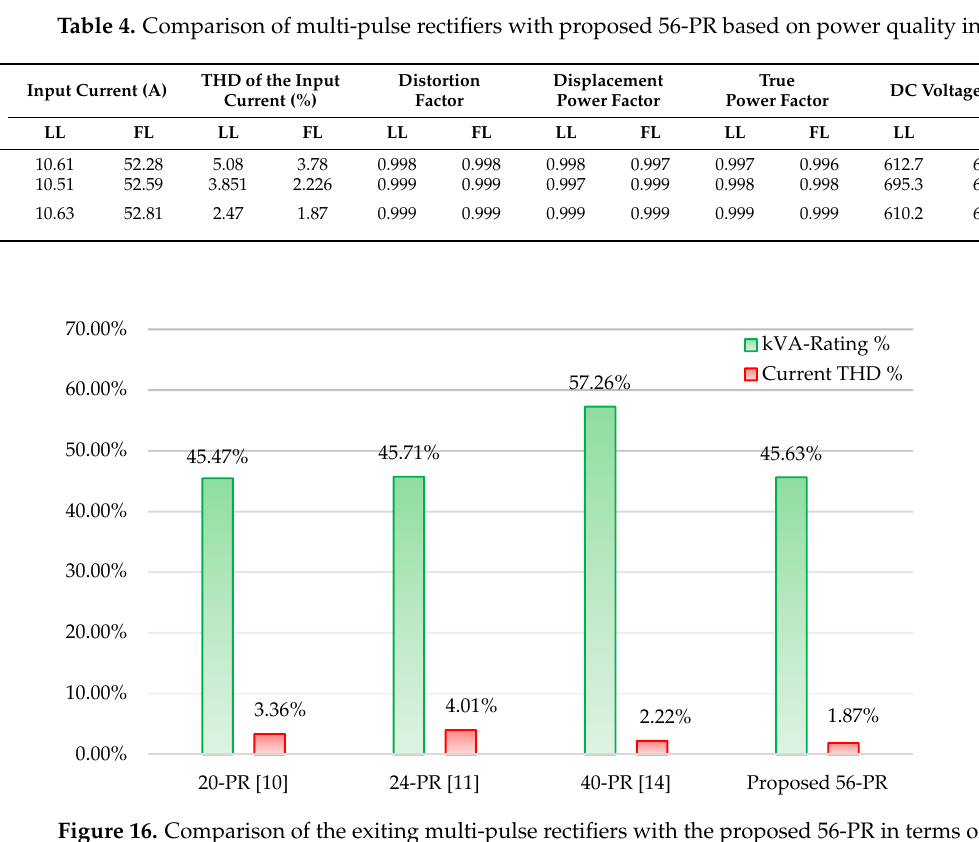
Table 4. Comparison of multi-pulse rectifiers with proposed 56-PR based on power quality indi- ces.